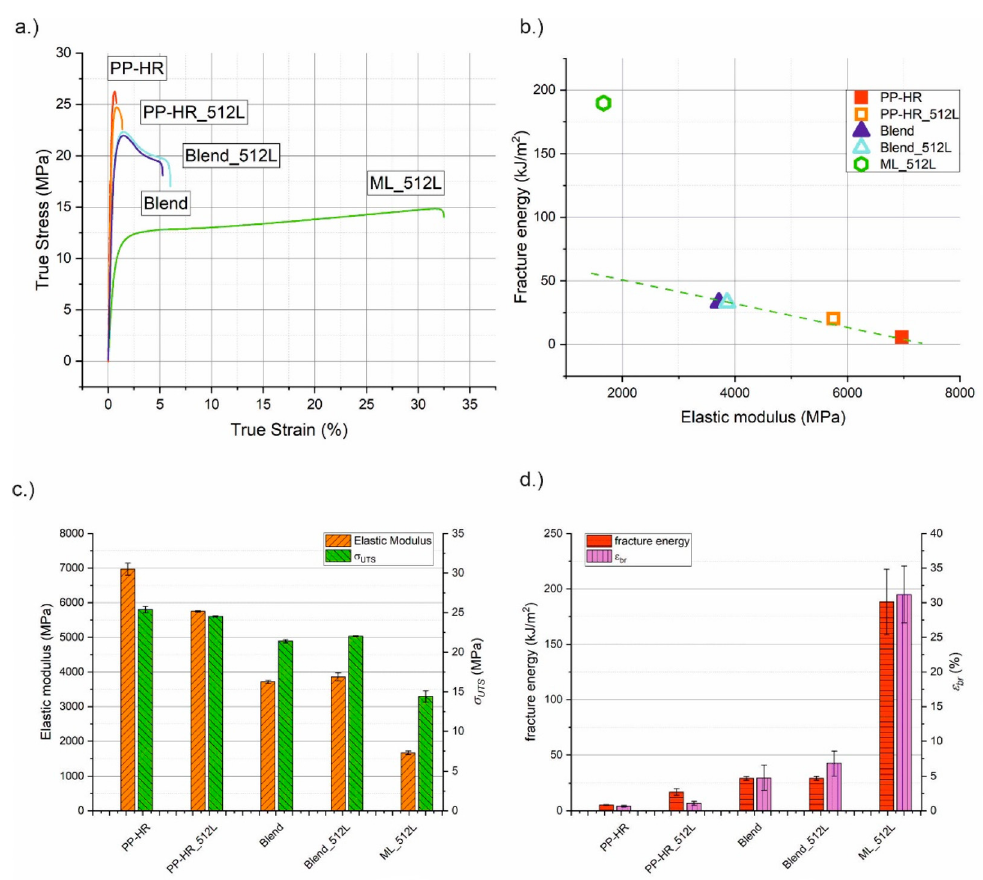
Figure 8. ( a ) Representative true stress–strain curves of all investigated materials in tensile tests and ( b ) an overview of the observed material parameters, where ( c ) the elastic modulus and ultimate tensile strength and ( d ) the fracture energy and strain at break are depicted in more detail.